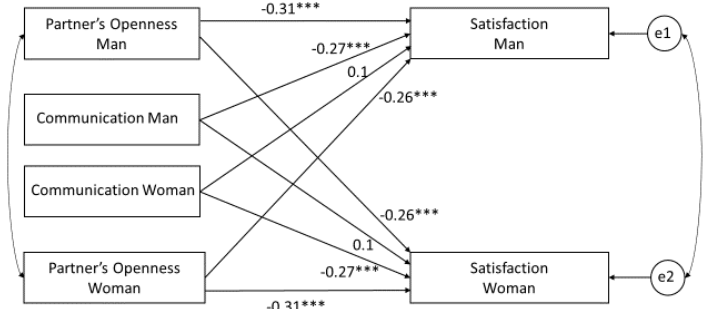
Figure 2. Generic actor–partner interdependence model with communication as the moderator. The rectangles represent the independent and dependent variables; the two circles (e1, e2) present the latent error terms; the single-headed arrows show regression coe ffi cients (the actor and partner e ff ects); the curved double-headed arrow on the right represents the correlation between the two error terms. Although not shown in the model, the communication–openness interactions were included as covariates. All predictors, including interaction terms, are allowed to covary. Note: “openness” is the opposite pole of “reservedness”. * p < 0.05; ** p < 0.01; *** p < 0.001. Table 4. E ff ects in the moderation